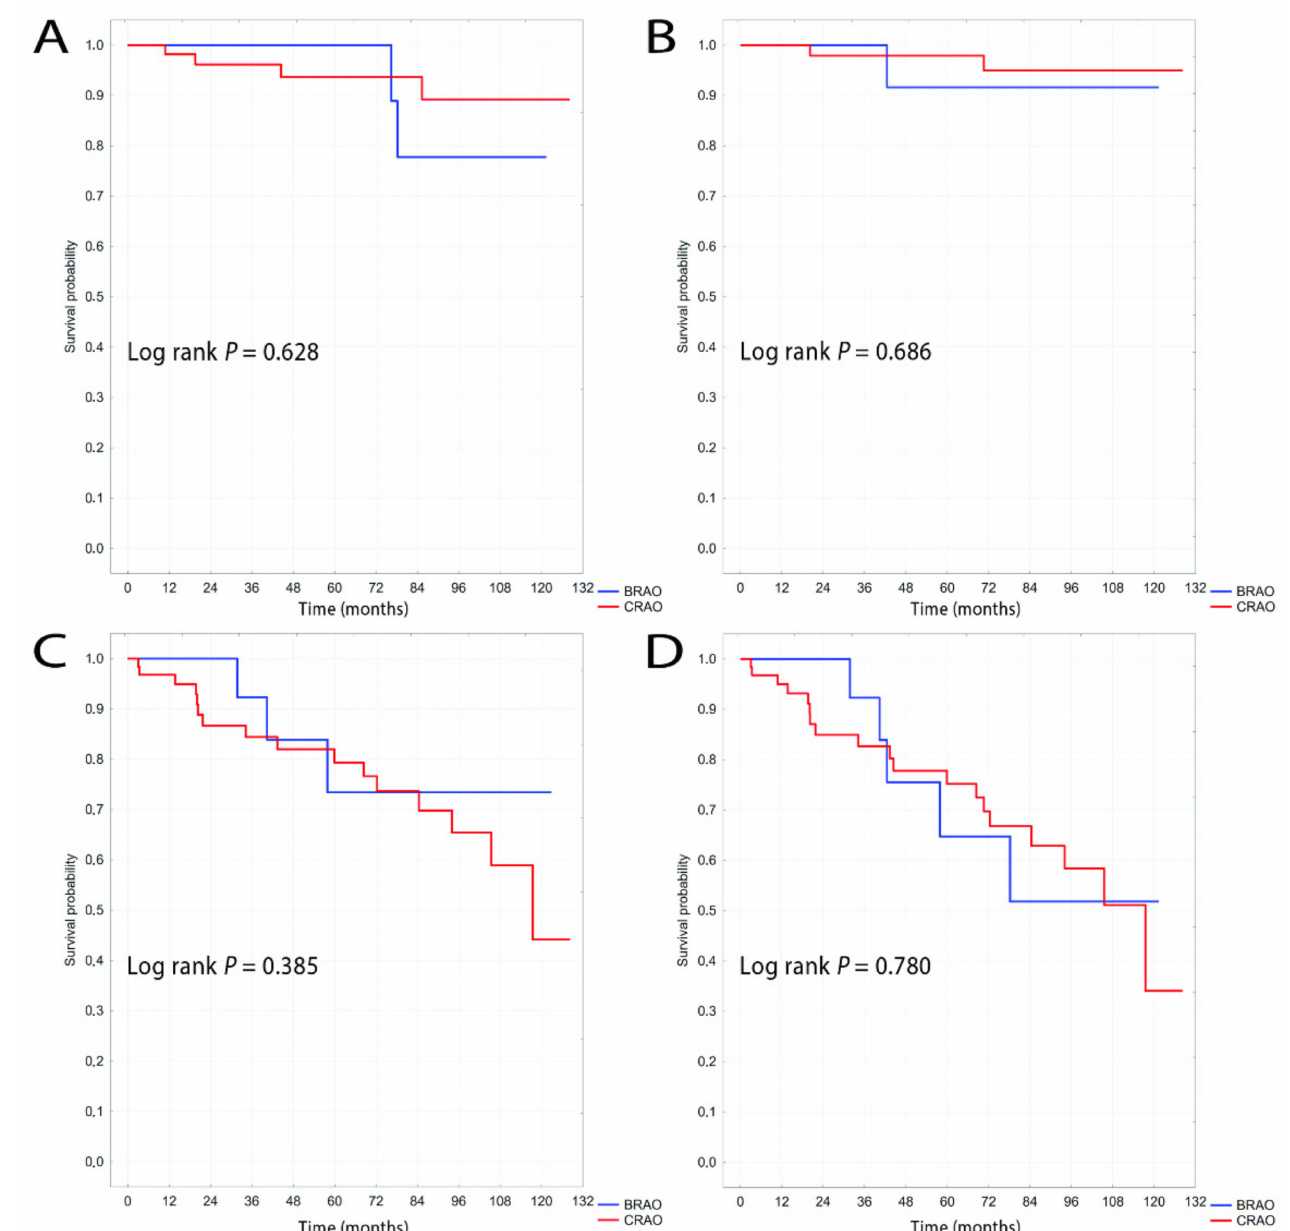
Figure 3. Kaplan-Meier curves of survival probability for subpopulation without cardiovascular events before RAO for ischemic stroke ( A ), myocardial infarction ( B ), all-cause mortality ( C ) and the composite endpoint ( D